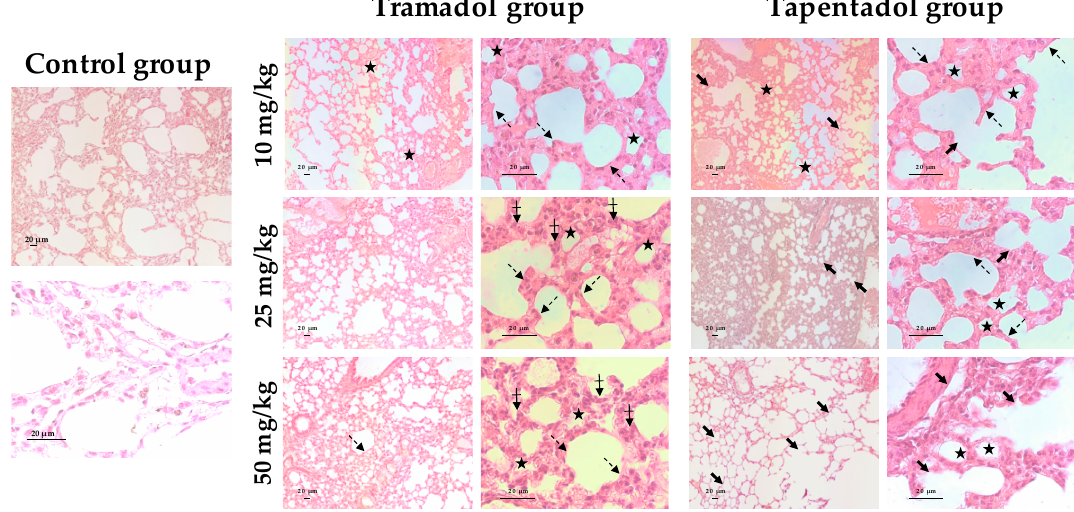
Figure 5. Photomicrographs of lung sections of Wistar rats intraperitoneally injected with different tramadol and tapentadol doses or saline (control group), for 14 consecutive days, upon hematoxylin and eosin (H & E) staining. Alveolar collapse (stars), alveolar wall thickening and hyperpigmentation (dashed arrows) and disorganized cells (vertical, crossed arrows), as well as alveolar destruction and loss of parenchyma (thick arrows), are observed. Photographs were taken with 100 × and 600 × magnifications. Scale bar, 20 µ m.